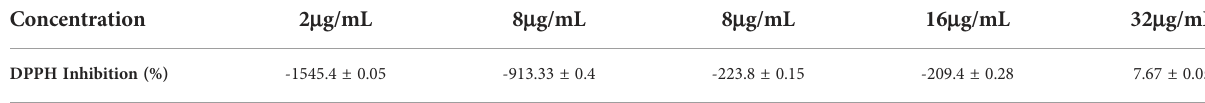
TABLE 3 DPPH scavenging activity of aqueous extract of Sargassum sp. Concentration